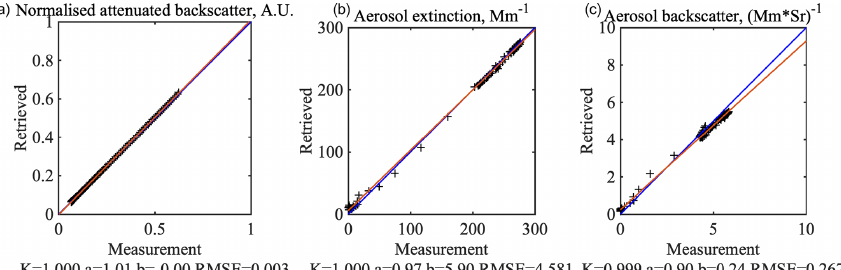
Figure 17. Achieved attenuated normalized inelastic backscatter (a) , aerosol extinction (b) and aerosol backscatter (c) fits for the synergy retrievals performed on 15–16 April 2015.